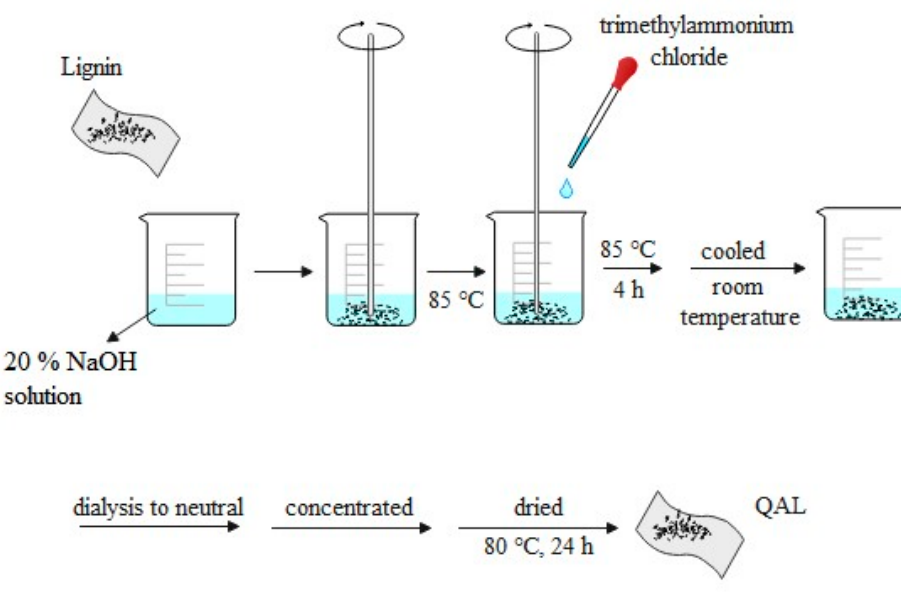
Figure 10. Activation of alkali lignin.